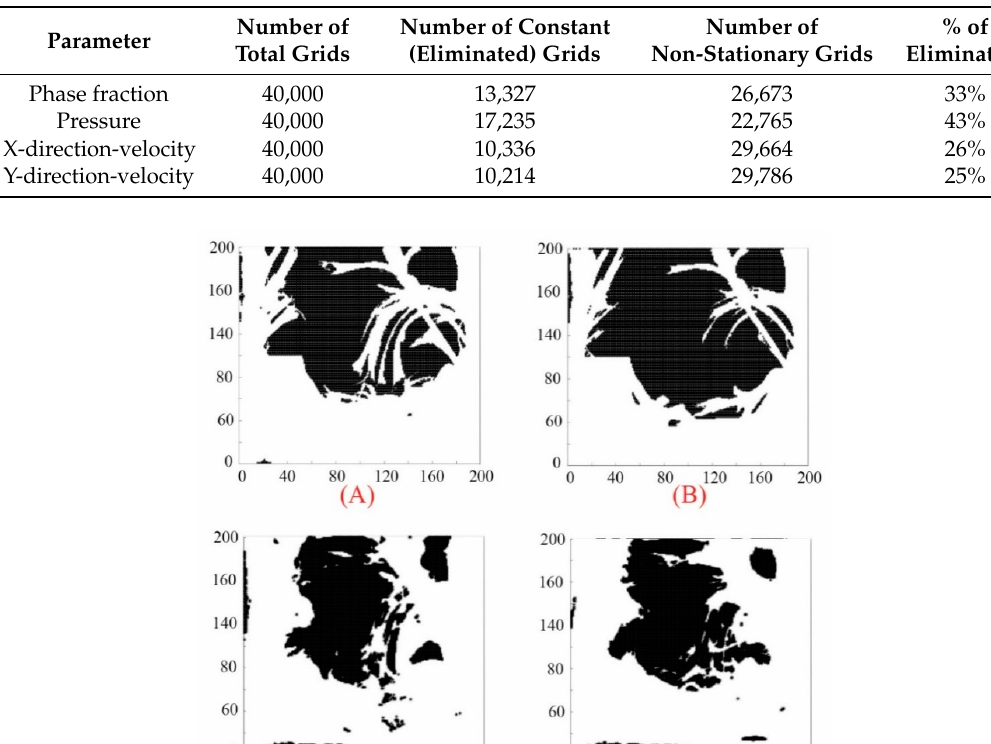
Figure 27. Eliminated grids for ( A ) phase fraction, ( B ) pressure, ( C ) x -direction-velocity, ( D ) y - direction-velocity. Table 4. Percentage of eliminated data for each parameter.